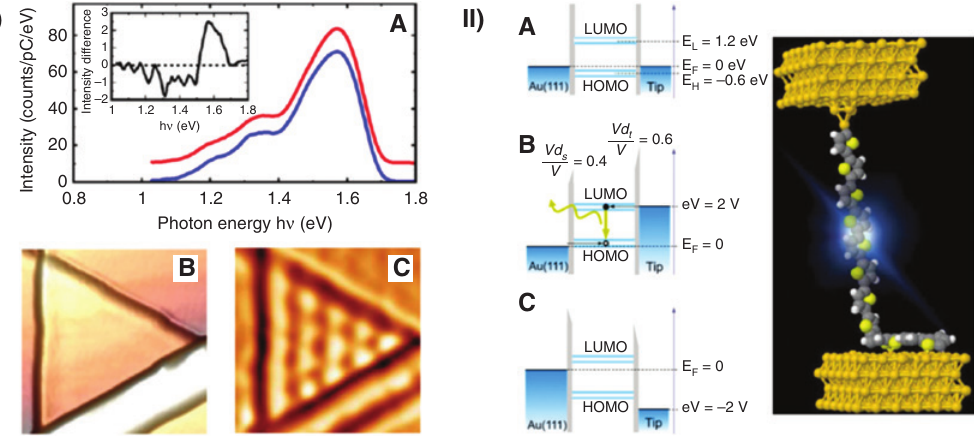
Figure 5: Modification of the IET light emission by a structure and a single molecule. I. (A) Spectra of STM-induced light emission from Au(111) obtained at two locations of a triangular island (B). The inset shows the difference between the spectra. (B) Constant-current STM image of a triangular island on Au(111). (C) Energy-resolved (1.65 eV < E < 1.7 eV) photon map acquired simultaneously with the STM image in B, taken with permission from [95]. II. Artistic image of the polymer junction and sketch of the band structure of the polymer junction representing the energies of the HOMO and LUMO states at (A) zero bias voltage. At a high negative sample voltage (B), the HOMO is shifted above the Fermi level of the sample and the LUMO below the Fermi level of the tip. Electrons injected from the tip into the LUMO can radiatively decay into the partially emptied HOMO. For inverse bias (C), the LUMO remains above the Fermi level of the sample, and no intramolecular radiative transition occurs, taken with permission from